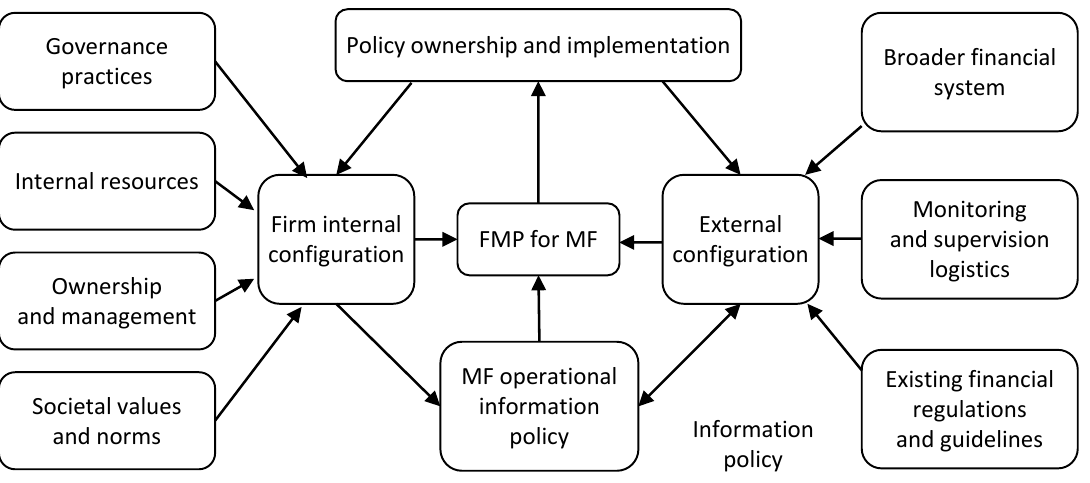
Figure 2. FMP model for MFIs